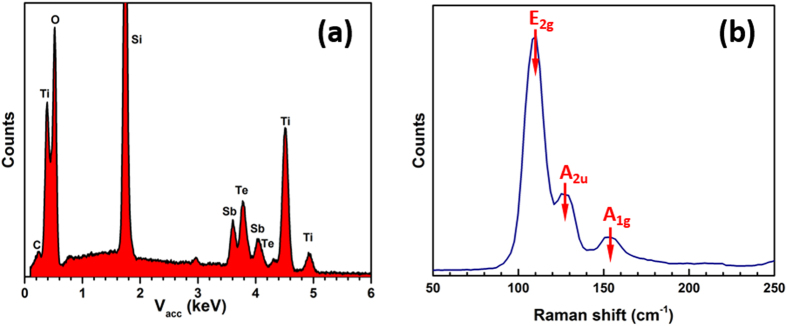
(a) EDX spectrum of a Sb2Te3 single nano-crystal in the hole; (b) Raman spectrum of the Sb2Te3 dense array.